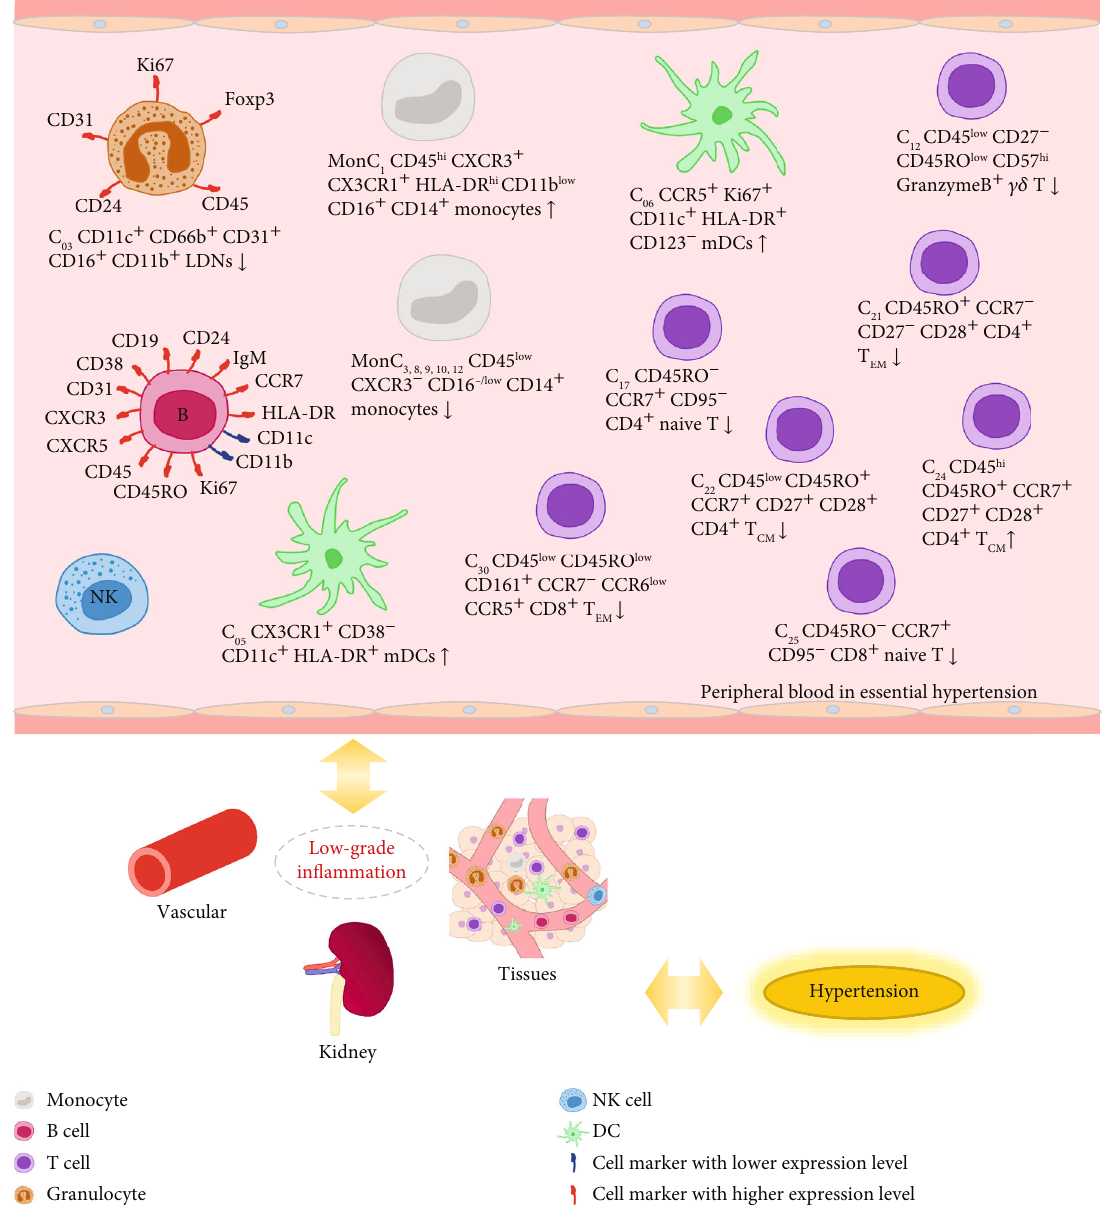
Figure 5: Summary and inference. The unbalanced immune state may be associated with the occurrence and development of hypertension by a ff ecting blood vessels, kidneys, and tissues closely related to hypertension. Maintaining the balance of immune status may be an important direction for improving essential